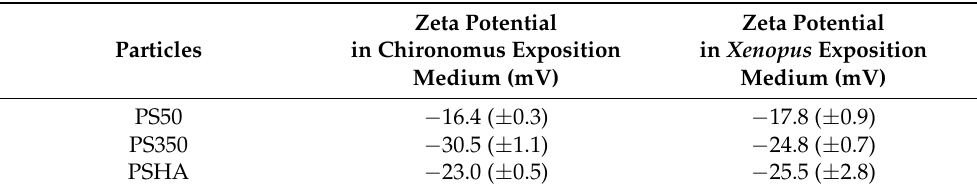
Table 3. Potential zeta of particles in the exposure media after the pH adjustment at 7 (10 mg L − 1 ). In brackets, the relative standard deviation values are reported.